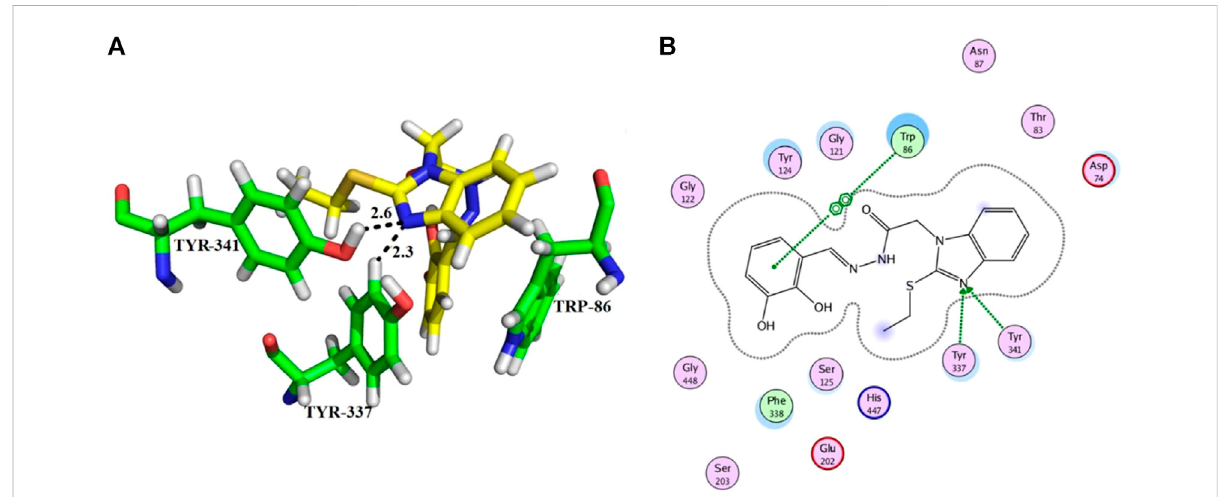
FIGURE 5 Showing the molecular docking conformation of compound 13 ( A,B ) in the active site of AChE.